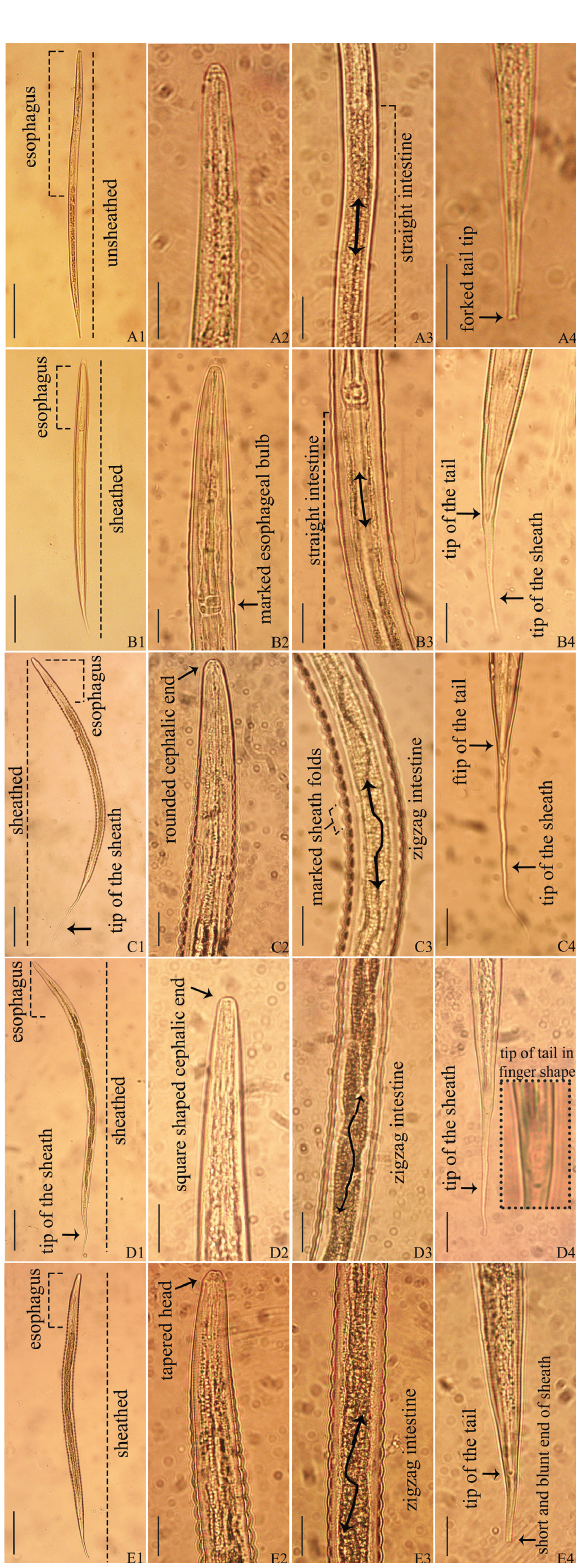
Figure 3: (a1)–(a4) Strongyloides larva obtained from swine. (a1). Long esophagus (approximately half the length of the larva), absence of sheath; (a3) straight intestine; (a4) forked tail end. (b1)–(b4) Hookworm larva obtained from human. (b1) Short esophagus (reaching 1/3 of the length of the larva), presence of sheath; (b2) marked esophageal bulb; (b3) straight intestine; (b4) tip of the tail. (c1)–(c4) Oeso- phagostomum larva obtained from swine. (c1) Short esophagus and presence of sheath; (c2) rounded cephalic end; (c3) accentuated sheath folds, zigzag intestine; (c4) long sheath. (d1)–(d4) Hyostrongylus larva obtained from swine. (d1) Short esophagus, presence of sheath; (d2) cephalic end in square shape; (d3) zigzag intestine; (d4) tip of the tail in finger shape. (e1)–(e4) Trichostrongylus larva obtained from swine. (e1) Short esophagus and presence of sheath; (e2) tapered cephalic end; (e3) zigzag intestine; (e4) short and blunt end of the sheath. A vertical bar in a1, b1, c1, d1, and e1 � 100 μ m. Bar in the other images � 20 μ